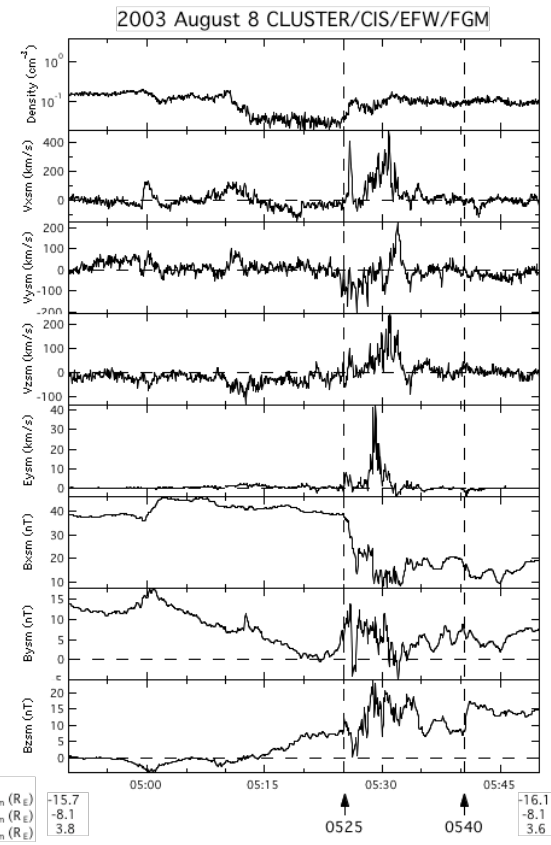
Figure 9 Fig. 9. Cluster measurements of plasma bulk flow from CIS/HIA (R`eme et al., 2001), y -component of the electric field from EFW (Gustafsson et al., 2001), and magnetic field from FGM (Balogh et al.,